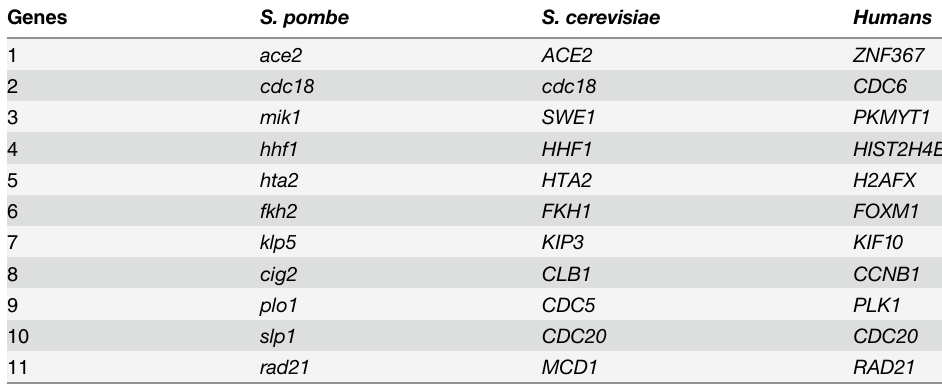
Table 1. Evolutionarily conserved human cell-cycle genes along with corresponding S. pombe and S. cerevisiae orthologs.